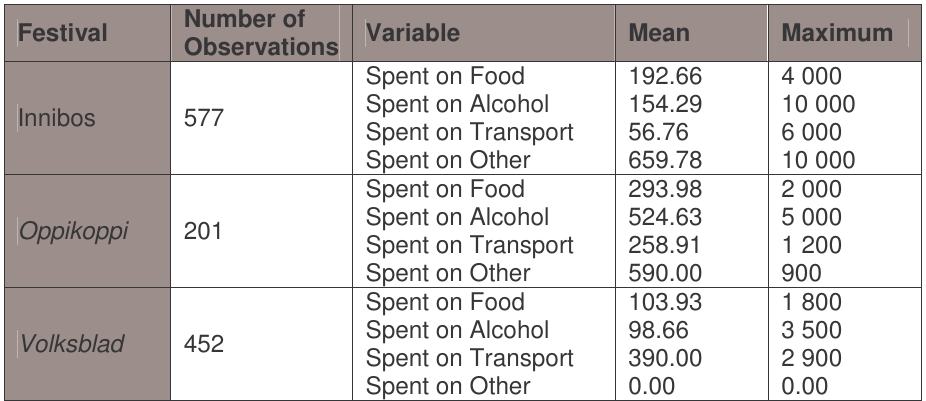
Table 9: Expenditure at festivals